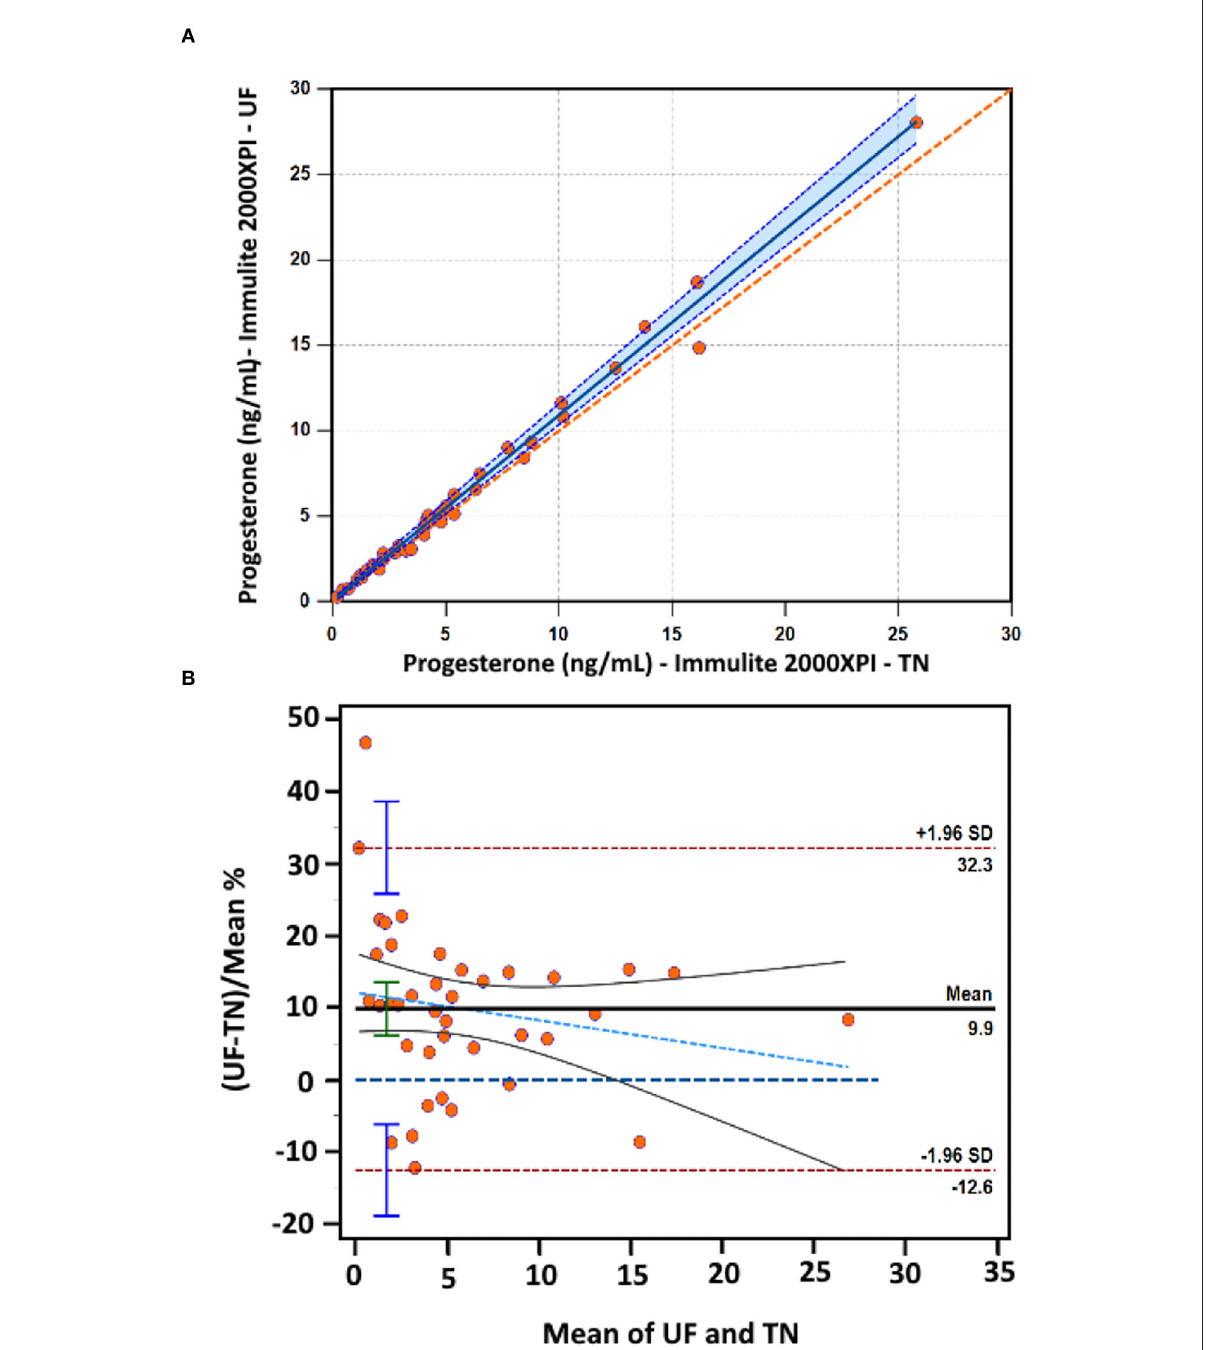
FIGURE5 (A) Scatterplot indicating the relationship between the plasma progesterone concentration ([P4]) measured by the IMMULITE ® 2000 XPi P4 immunoassay at the University of Florida (UF) and at the University of Tennessee (TN). The orange dashed diagonal line is the line of identity, and the solid blue line is the line of best fit from Passing-Bablok, and the light blue shaded area is the 95% confidence interval (CI). (B) Bland-Altman mean percentage difference plot. The horizontal black solid line represents the mean bias percentage and the horizontal maroon long dashed lines reflect the 95% limits of agreement. The horizontal solid blue long dashed line represents the line of identity. The light blue long dashed line and surrounding gray solid lines represent the regression line and the 95% CI, respectively. The vertical blue and green bars indicate the 95% confidence